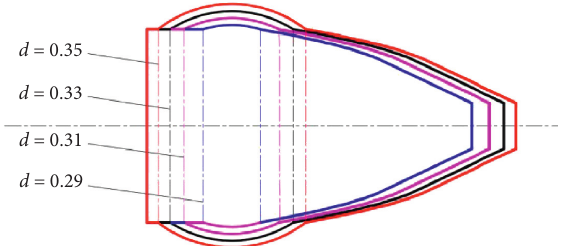
Figure 2: Schematic diagram of the hub ratio of the runner.